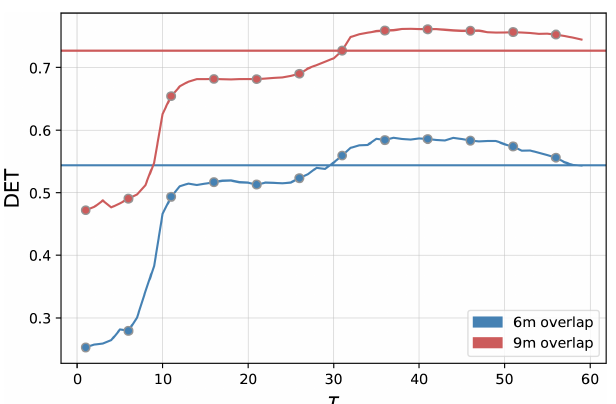
Figure 16. Distribution of the DET value of surrogate data (blue) and the original DET value